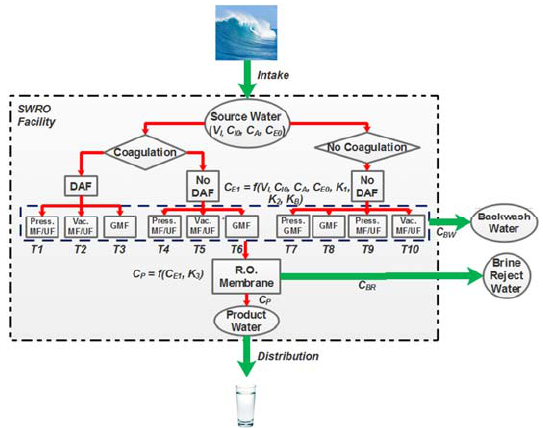
Figure 1. Conceptual pMFA diagram for the full ‐ scale SWRO desalination facility. The boundaries of the SWRO facility are indicated by the dashed black line, while pretreatment unit processes trains (T1 ‐ T10 ) are grouped by the dashed blue line. The arrows indicate toxin mass flow rates expressed in μ g/day, simplifying to a mass of toxin (in μ g) on the timescale of one day. The red arrows specify mass flows within the desalination facility control volume, whereas the green arrows indicate mass flows of toxins out of the control volume.